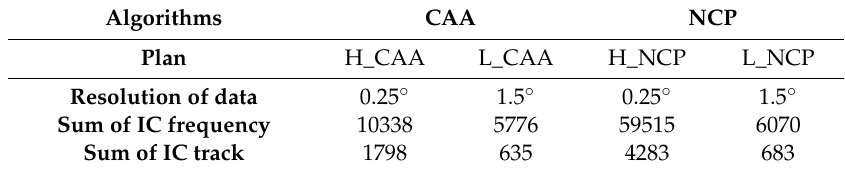
Table 4. Sensitivity of the two algorithms derived by two horizontal resolutions.